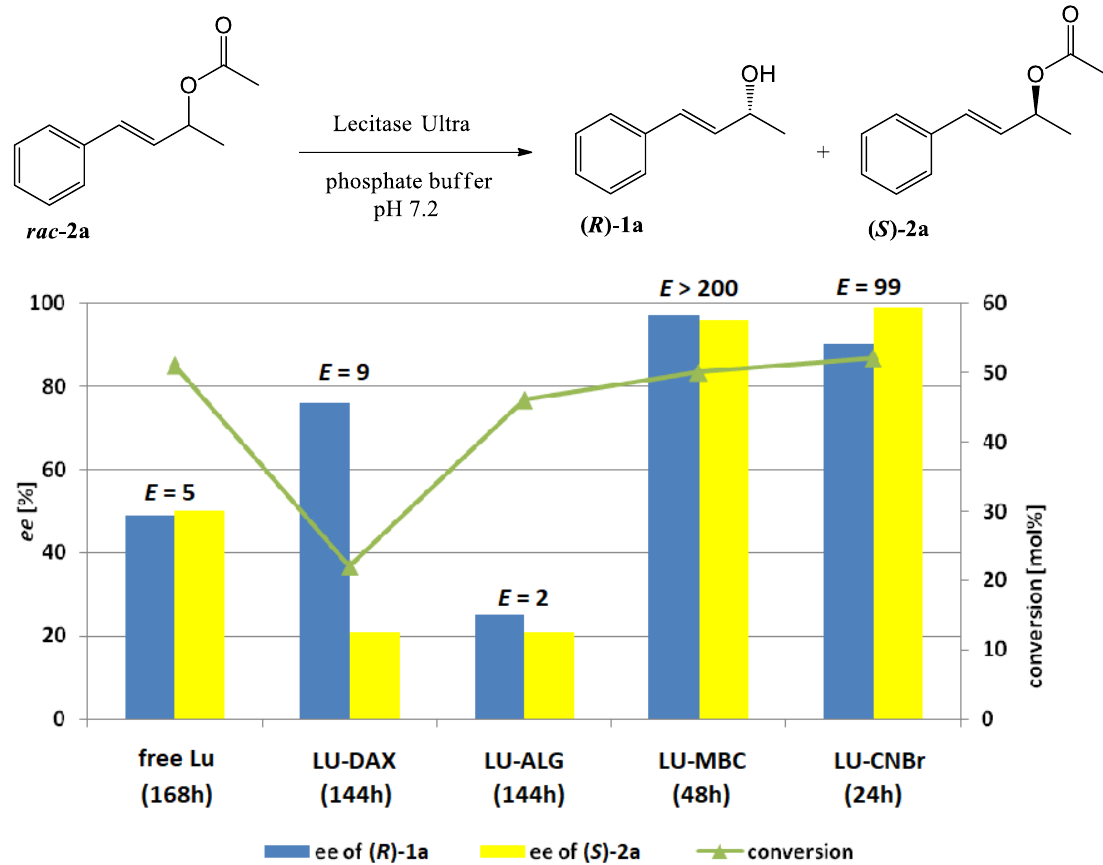
Figure 1. The effect of enzyme immobilization on the conversion, enantioselectivity, and enantiopurity of the products of Lecitase ™ Ultra-catalyzed hydrolysis of racemic acetate 2a (reaction scheme presented above)